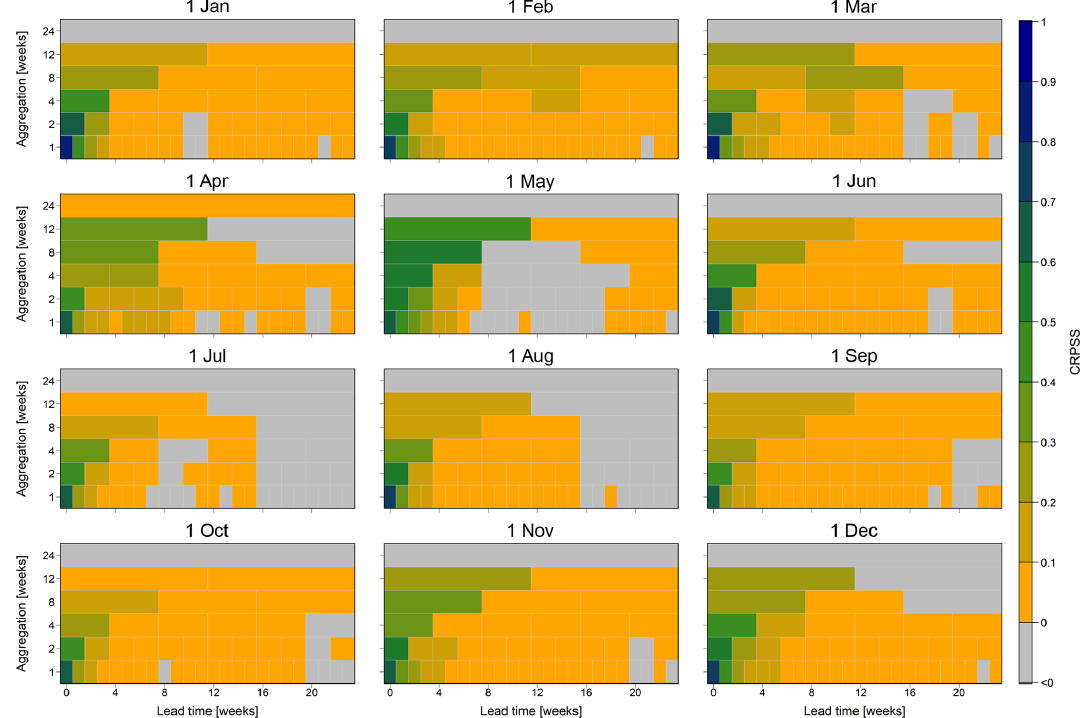
Figure 5. Skill of streamflow forecasts as a function of lead time (weeks) initialized on the 1st of each month for selected forecast aggregation periods (i.e. 1, 2, 4, 8, 12, and 24 weeks). The skill is averaged over